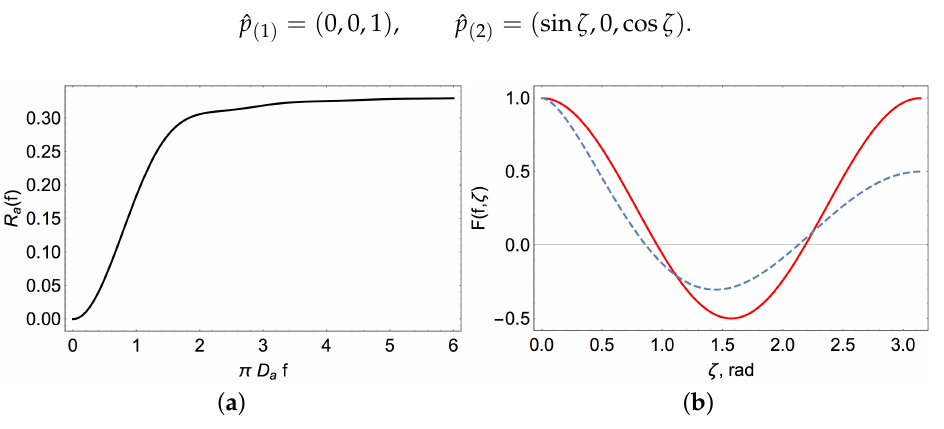
Figure 7. ( a ) The response function, Equation (54); ( b ) Normalized angular part of the cross-spectrum in the short-wavelength (dashed line) and long-wavelength (solid line) limits, Equation